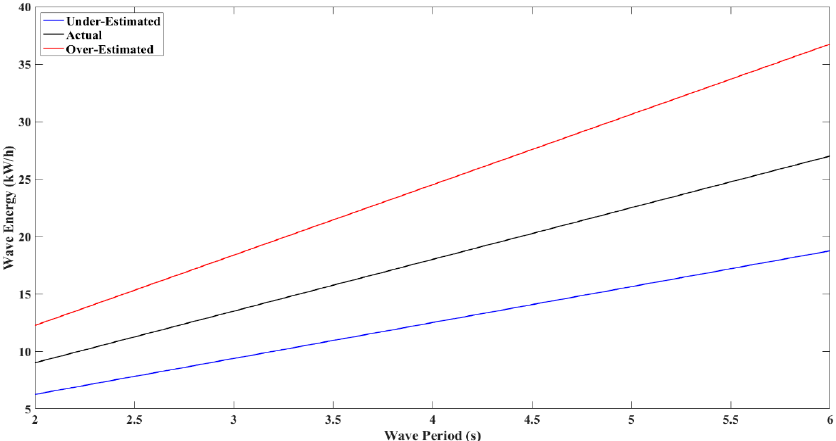
Figure 8. Hypothetical consequences of under (blue) and overestimating (red) a 3 m significant wave height (black) by ± 0.5 m. Table 2. Comparison of error statistics between LSTM and EMD-LSTM, in addition to the degrees of improvement for the 3, 6, 9, 12, 24, 48 and 72 h forecast windows for NDBC buoys 41046 and 41047.